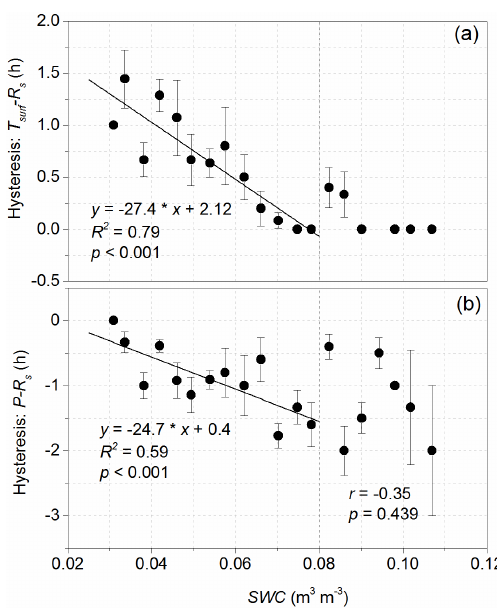
Figure 6. Time lags between soil respiration ( R s ) and soil- surface temperature ( T surf ) , R s , and photosynthesis at an Artemisia ordosica -dominated site with respect to soil water content (SWC). Time lags were bin-averaged using SWC intervals of 0.004m 3 m − 3